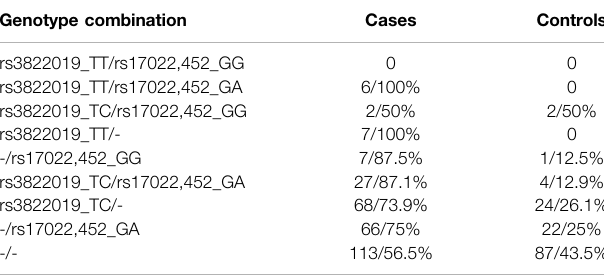
TABLE 3 | PD cases and controls among bearers of the respective genotype combinations of the identi fi ed variants rs3822019 and rs17022,452. Genotype combination